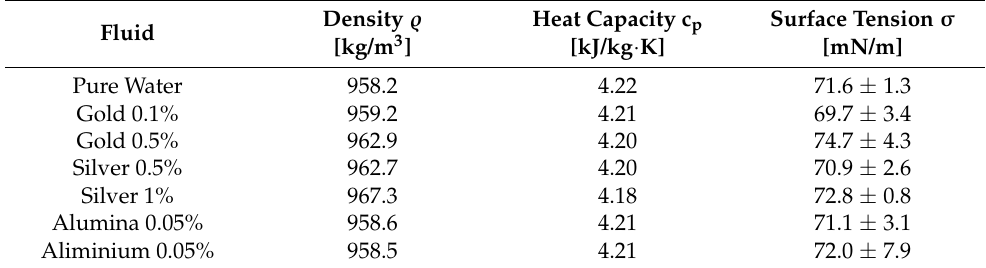
Table 1. Thermophysical properties of the working fluids at temperature of 293.15 K at 1 × 10 5